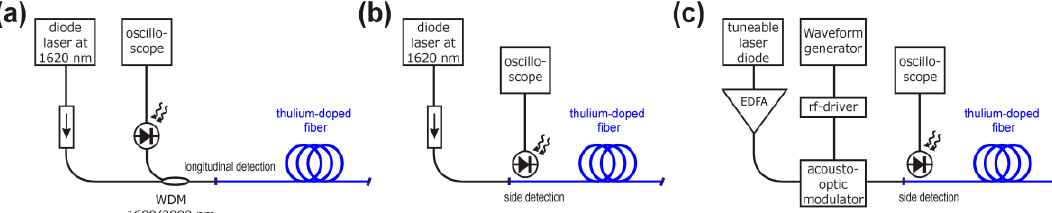
Figure 1. Fluorescence lifetime measurement setups: ( a ) detection in longitudinal direction via wavelength-division multiplexer (WDM), ( b ) side detection using modulated pump laser diode, ( c ) side detection using high-power EDFA and acousto-optic